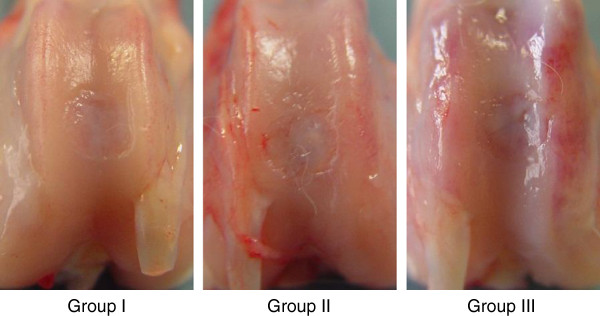
In gross observation, the defects in Groups I and II were filled with a white opaque elastic tissue, while the defects in Group III showed reddish patchy tissues.